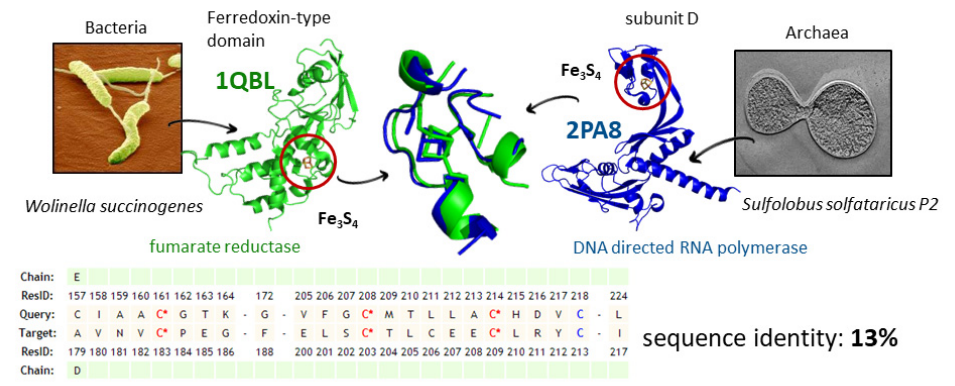
Figure 3. Detection of relationships between MPs with divergent sequences. MBS-driven structural superposition permits the detection of similarities between proteins with no homology, or which have experienced extensive sequence divergence. PDB entry 2PA8 is the crystal structure of the D/L subcomplex of the RNA polymerase of Sulfolobus solfataricus [51]. PDB entry 1QLB is the crystal structure of fumarate reductase from the respiratory complex II-like of Wolinella succinogenes [52]. This example superposition was computed with the MetalS 2 [53] tool.